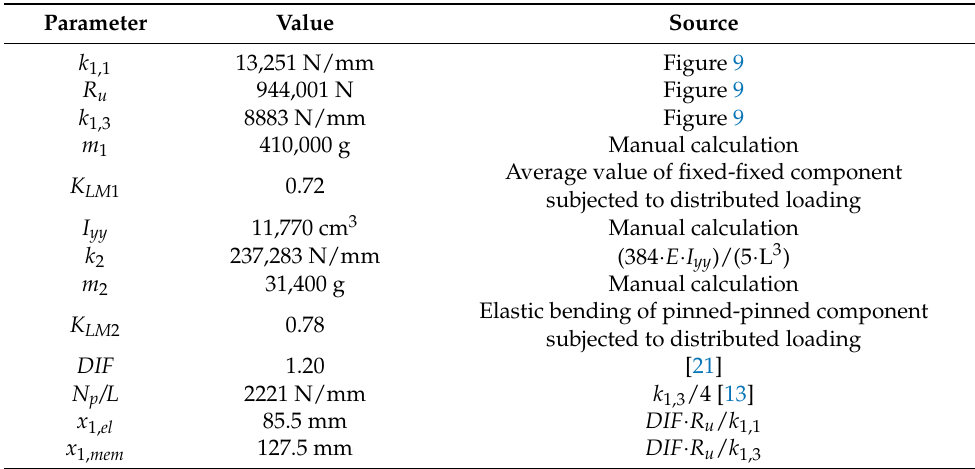
Table 2. Parameters of the two-step SDOF